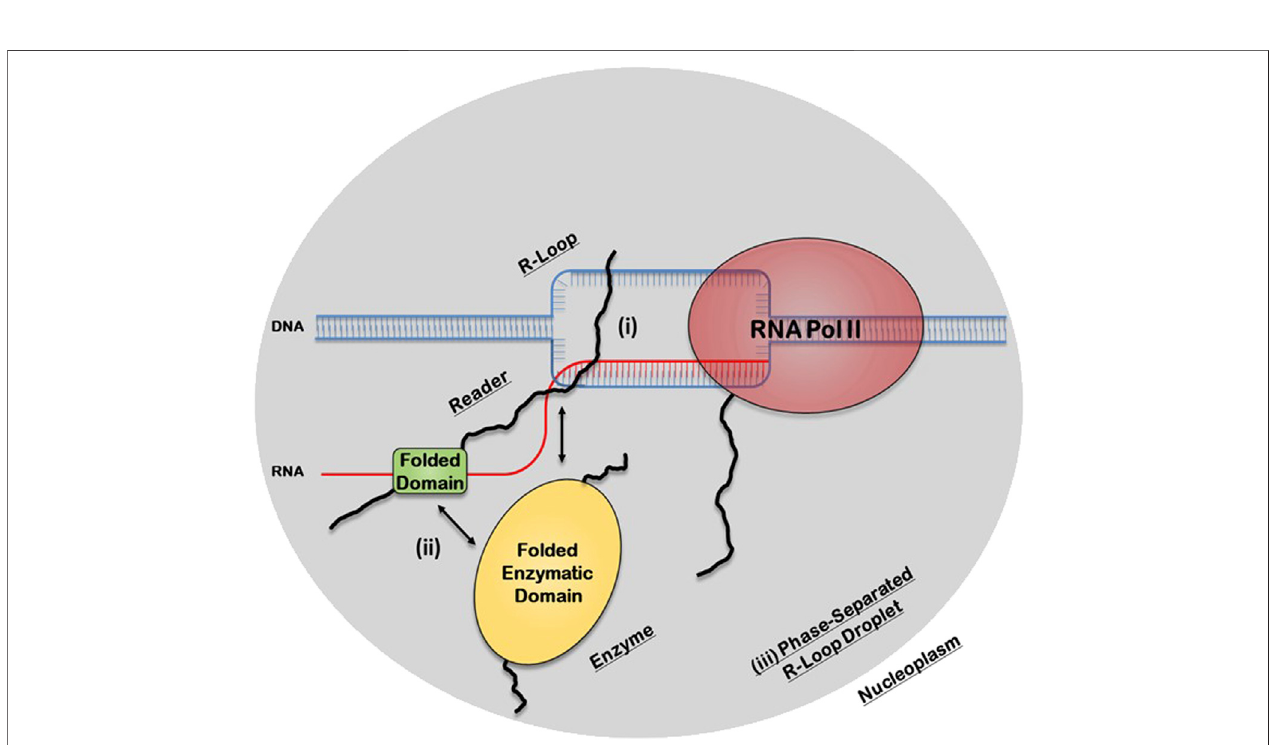
FIGURE 2| Potential structural mechanisms by which IDRs and folded domainsof R-loop proteins can synergize toregulatethe biological functions of R-loops. In the fi rst mechanism (i), the IDR is directly involved in the recognition of the R-loop structure itself, while in the second mechanism (ii), the folded domain does the binding andtheIDRisinvolvedinrecruitingotherR-loopprocessingfactors.Inthethirdmechanism(iii),theIDR,inconcertwiththefoldeddomainsandtheR-loopstructureitself, can mediate the assembly of membraneless R-loop processing and signaling foci via transient multivalent intermolecular interactions.